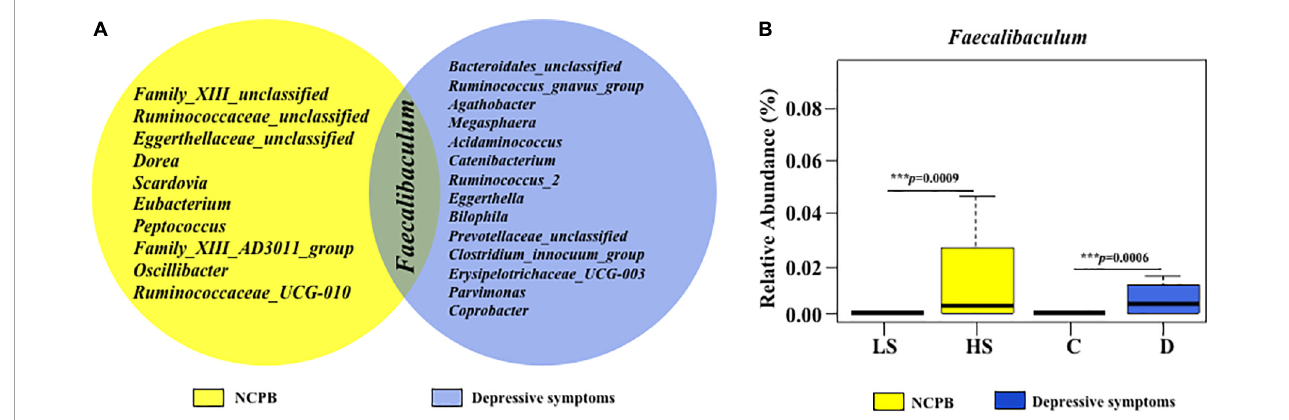
FIGURE6 Analysis of commonly associated genera with NCPB and depressive symptom groups. (A) The common associated genera with NCPB and depressive symptom groups (B) as well as the results of Faecalibaculum . HS, the high-status NCPB; LS, the low-status NCPB; D, the depression symptom group; C, the control